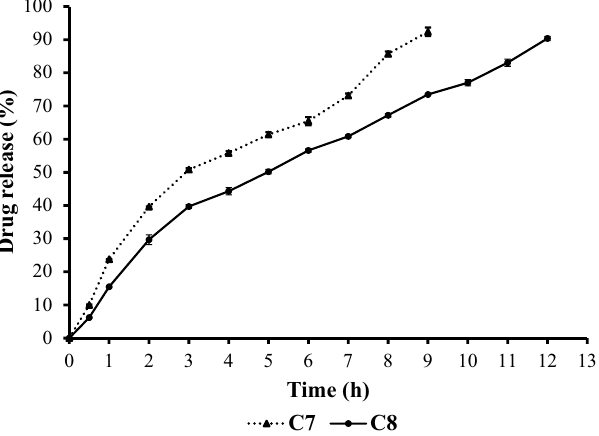
Figure 3. Percentage drug release of CLN-free base from C7 and C8 formulations against time (h). Data are expressed as mean ± SD (n = 3).